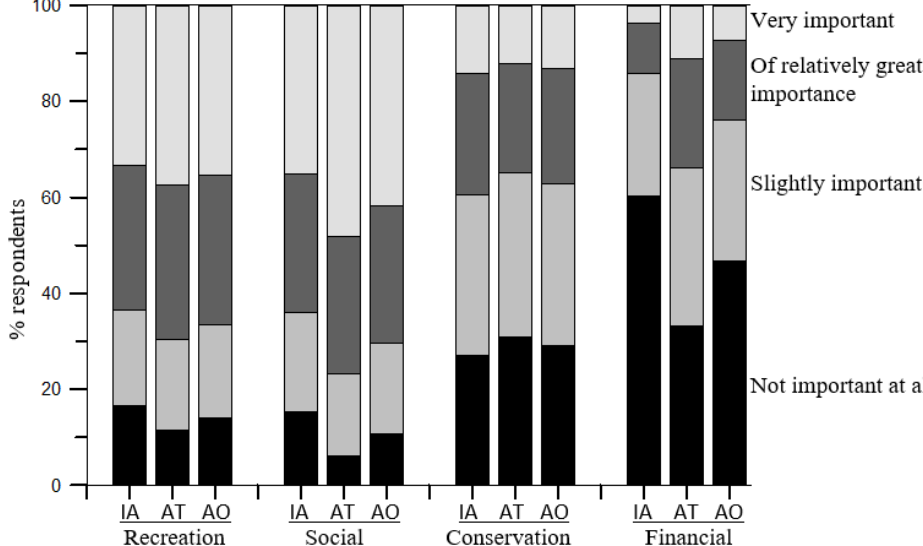
Figure 1. Objectives for owning non-industrial private forest (NIPF) among Active (AT), Inactive (IA), and All owners (AO).